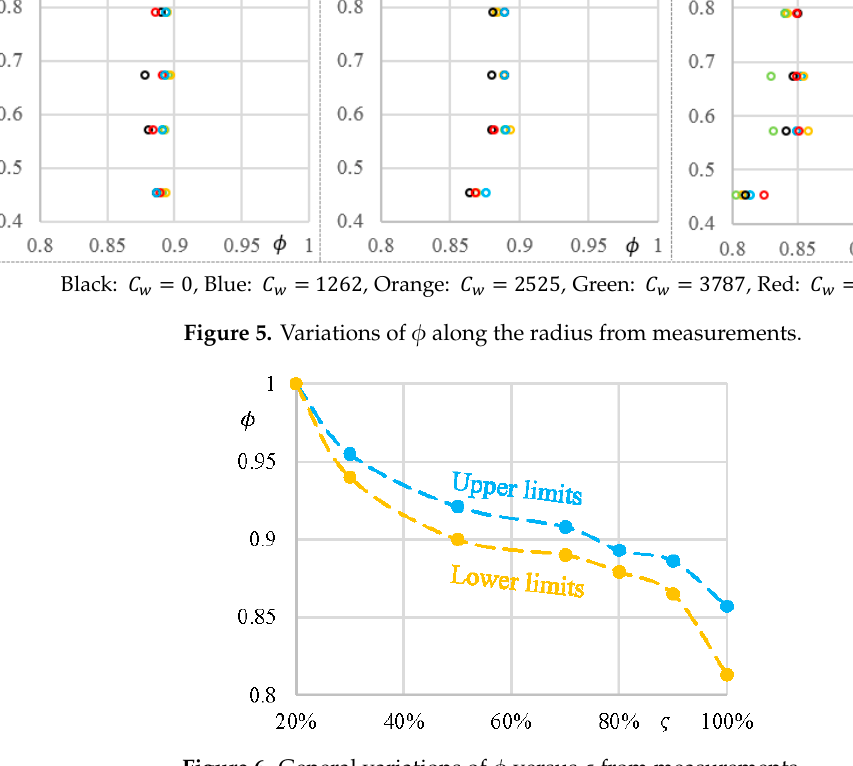
Figure 6. General variations of 𝜙 versus 𝜍 from measurements.